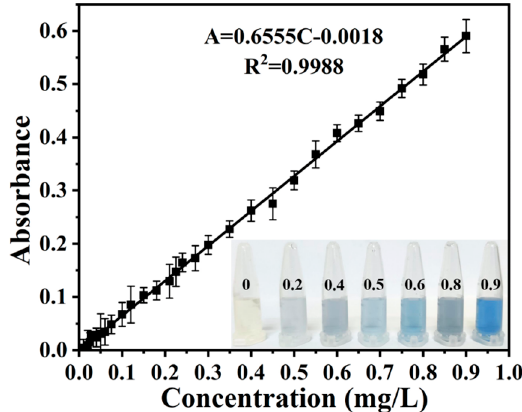
Figure 4. Calibration and standard curve of concentration of total phosphorus as function of absorbance; inset shows the color of the pre-validation solution samples converted with orthophosphate with different concentrations by the chromogenic reaction.